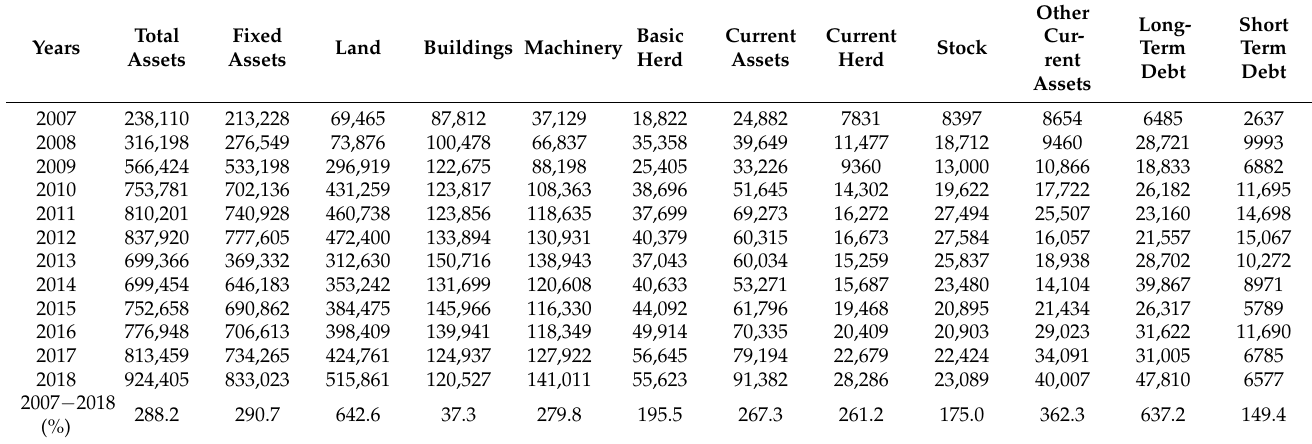
Table 9. Fixed and current assets of dairy organic farms in Poland in 2007–2018 (in